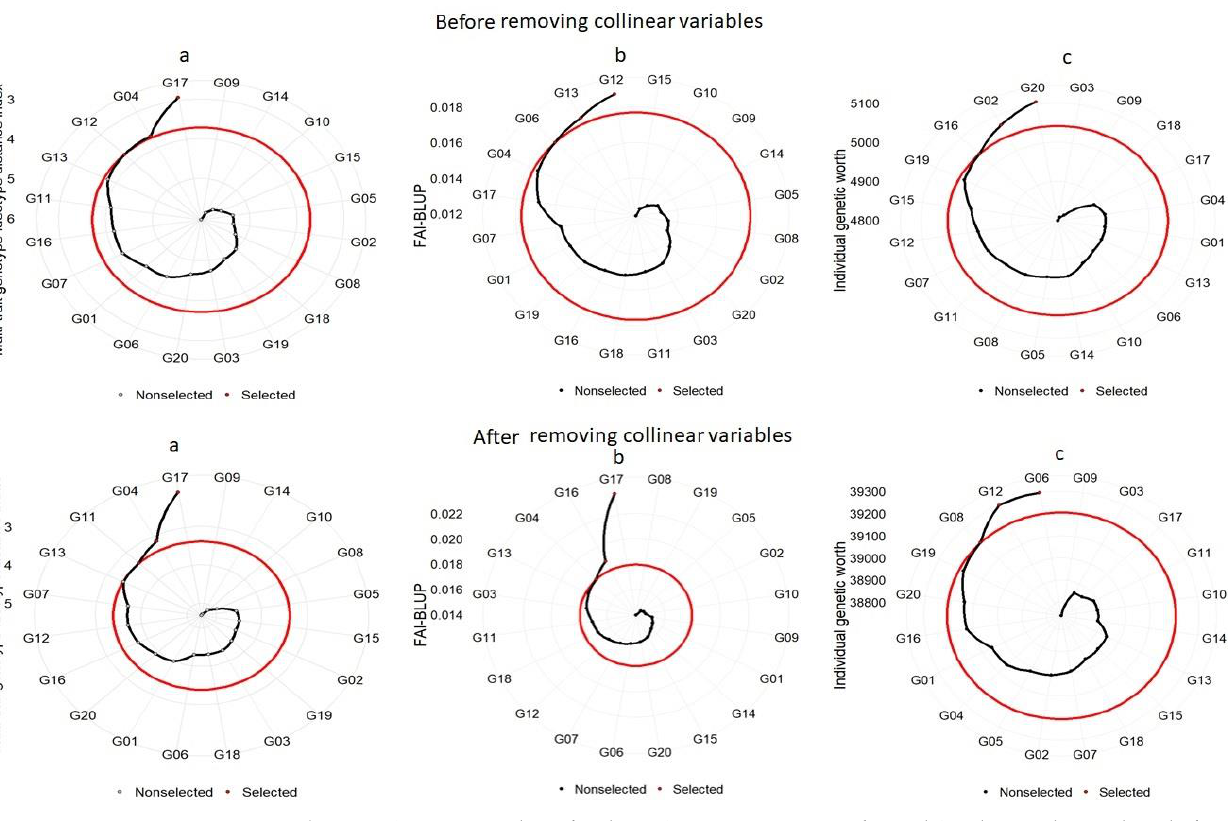
Figure 3. Genotype ranking for the MGIDI ( a ), FAI-BLUP ( b ), and Smith – Hazel ( c ) indices before and after removing the traits.